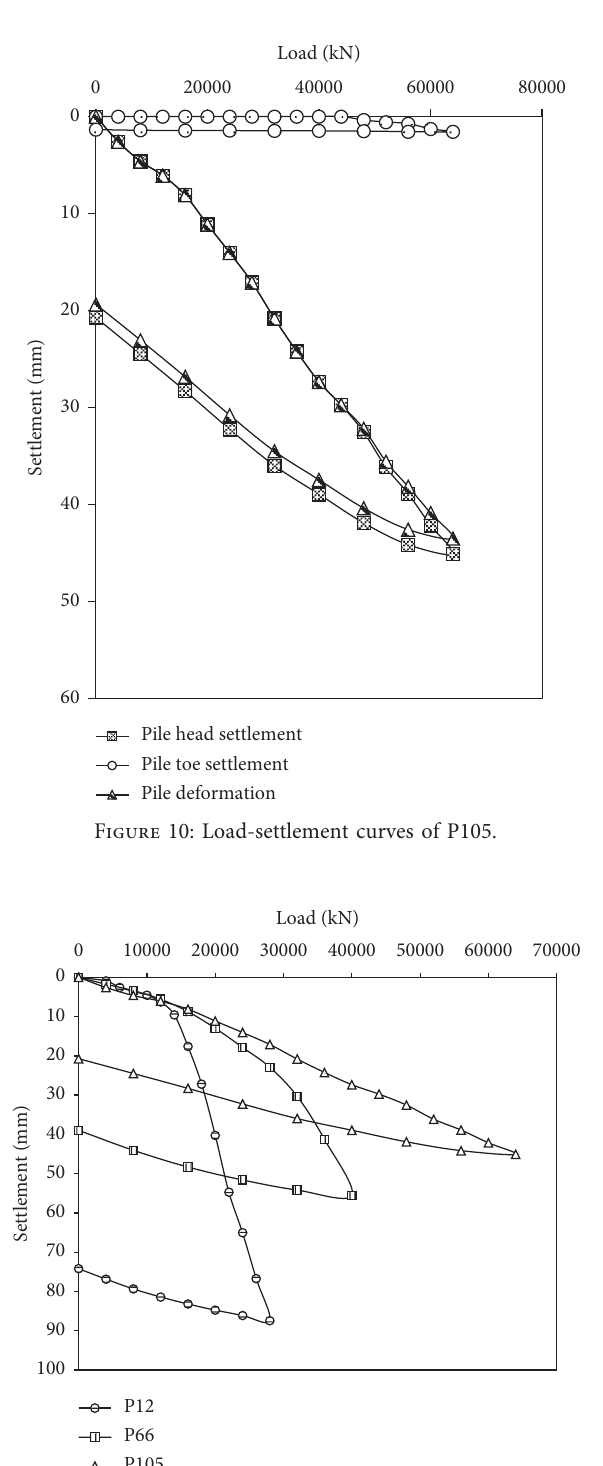
Figure 11: Load-settlement curves of tested piles.